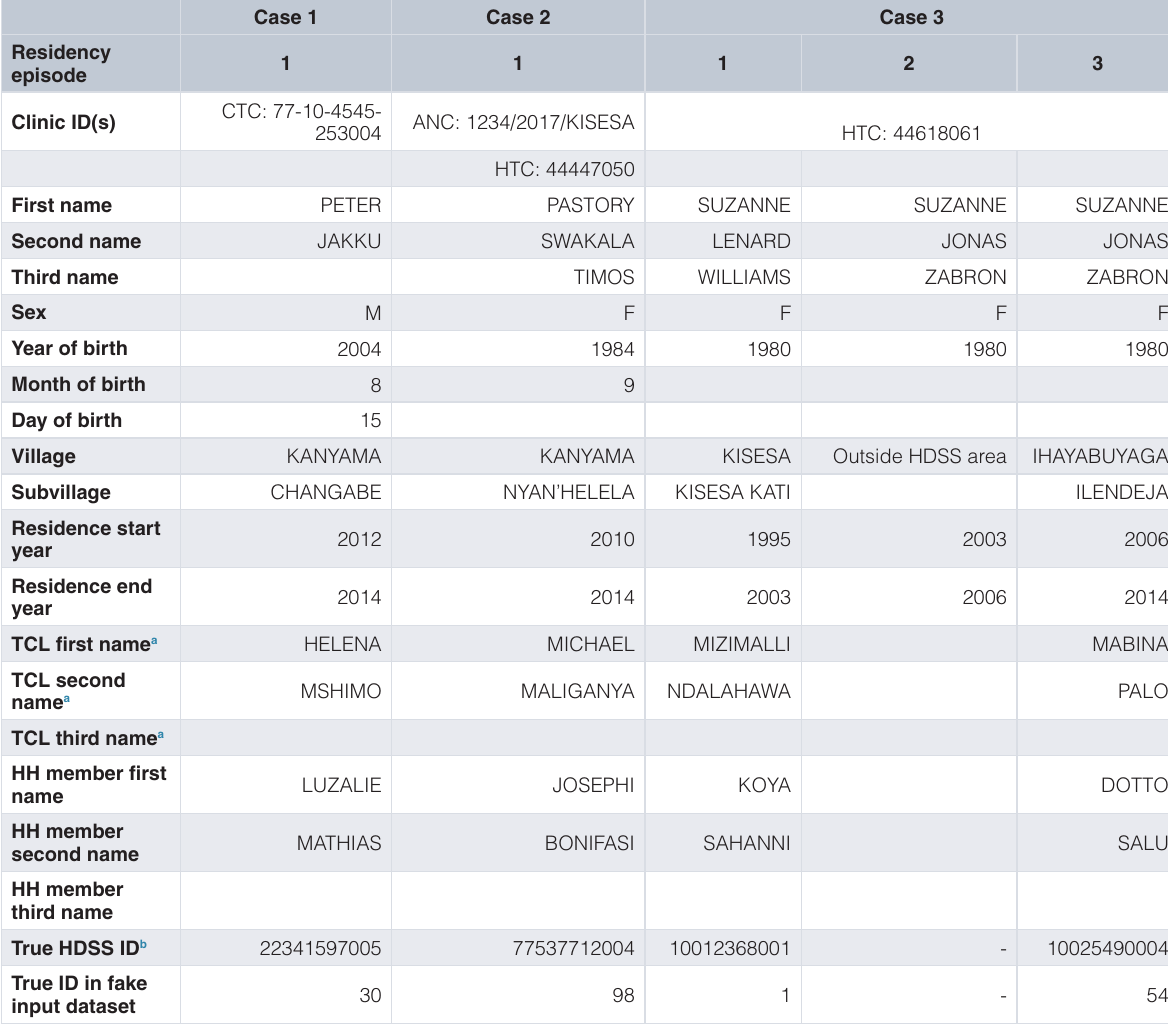
Table 1. Personal identifiers used for three case patients sampled from the fake dataset with varying numbers of residency